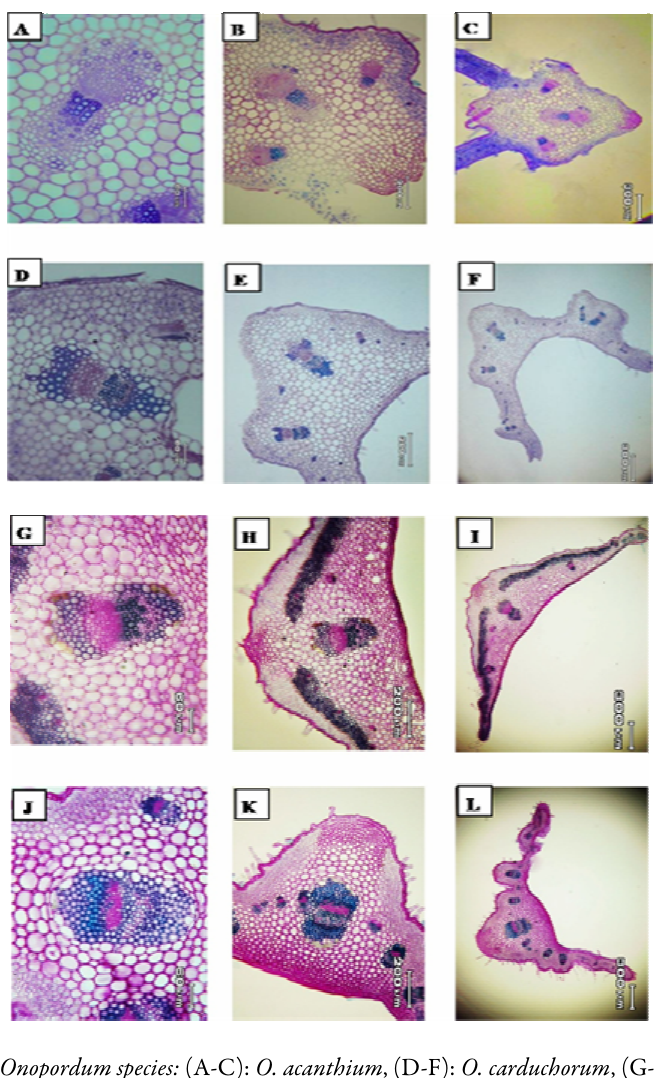
Fig. 3. Cross section of leaf in Onopordum species: (A-C): O. acanthium , (D-F): O. carduchorum , (G-I): O. armenum . (Scale bar=200µm in B, E, K, H, X= 40; Scale bar=60 µm in A, G, D, J, X= 100; Scale bar=300 µm in C, F, I, L, X=20)